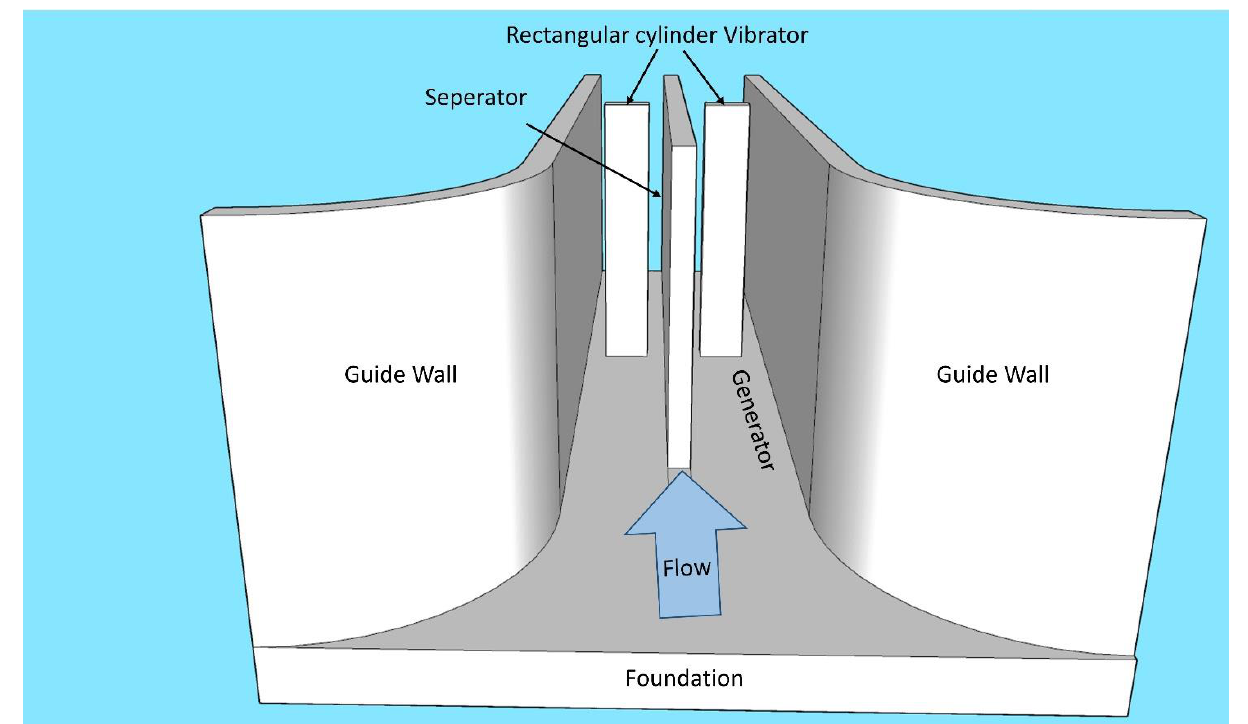
Figure 1. Conceptual diagram of the VIVACE device.